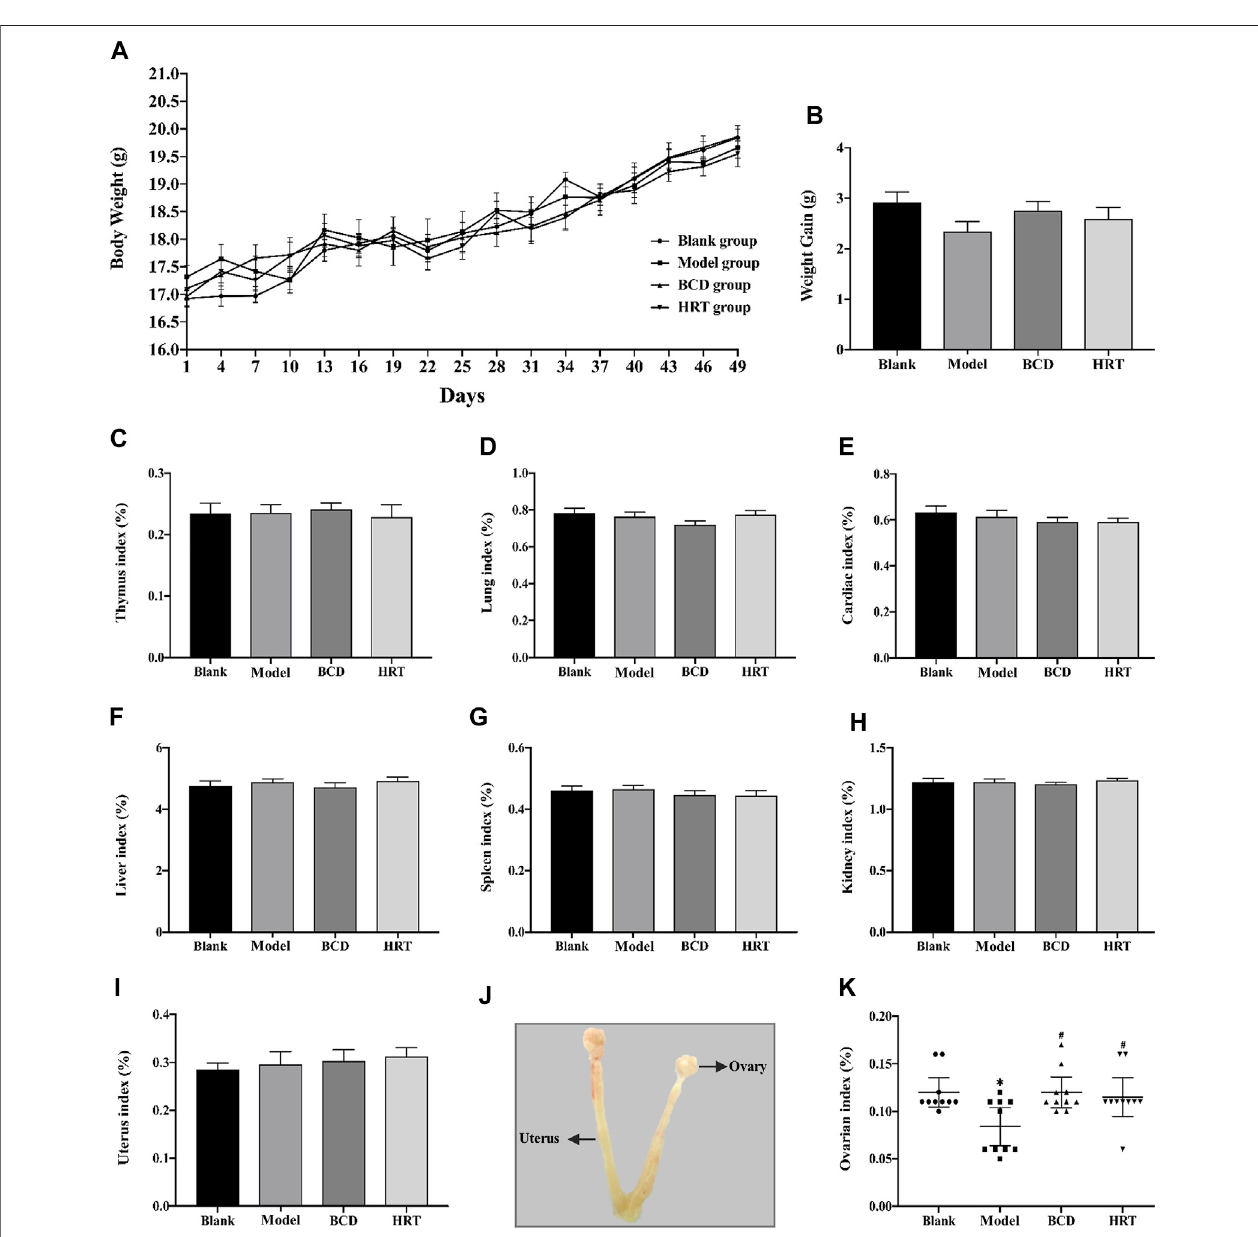
FIGURE 2 | The impact of BCD on the body weight and organ indices of POI mice. (A) Body weights of mice of all four cohorts. Cumulative mice body weights in those of the Model, BCD, and HRT groups were all down-trending with TWP treatment during the fi rst week. After this, all mice demonstrated increased body weights that were similar between all four groups. (B) Weight gain from baseline to sacri fi ce. (C) Thymus index. (D) Lung index. (E) Cardiac index. (F) Liver index. (G) Spleen index. (H) Kidney index. (I) Uterus index. (J) Uterus and ovarian anatomical diagram. (K) Ovarian indices of mice from all four groups. Data is visualized in terms of mean ± SEM. ( n = 10, * p < 0.05, ** p < 0.01, compared with the Blank group; # p < 0.05, ## p < 0.01, compared with the Model